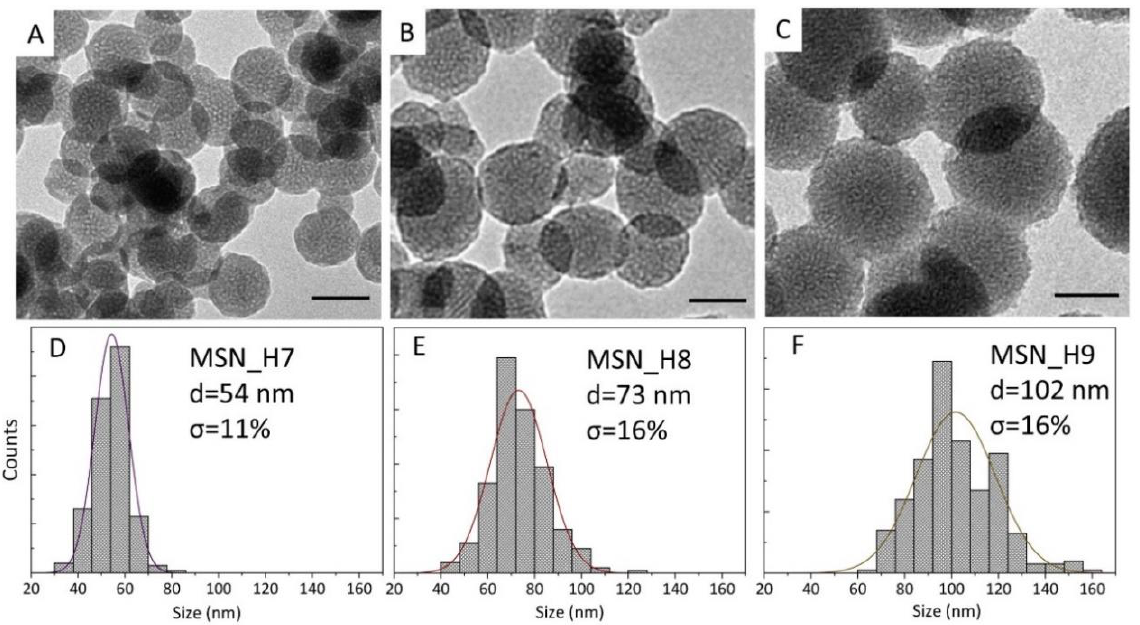
Figure 2. TEM micrographs (( A – C ), scale bar 50 nm) and the corresponding size distribution statistical analysis ( D – F ) of MSN_H7 ( A , D ), MSN_H8 ( B , E ) and MSN_H9 ( D , F ). Table 1. Reaction conditions used for the MSNs synthesis following the homogenous solution approach and average size and size distribution of the obtained samples, determined by TEM characterization. (*) and (**) correspond to amorphous structures and barely defined spherical particles, respectively (see Figure S1 in the Supplementary Materials).